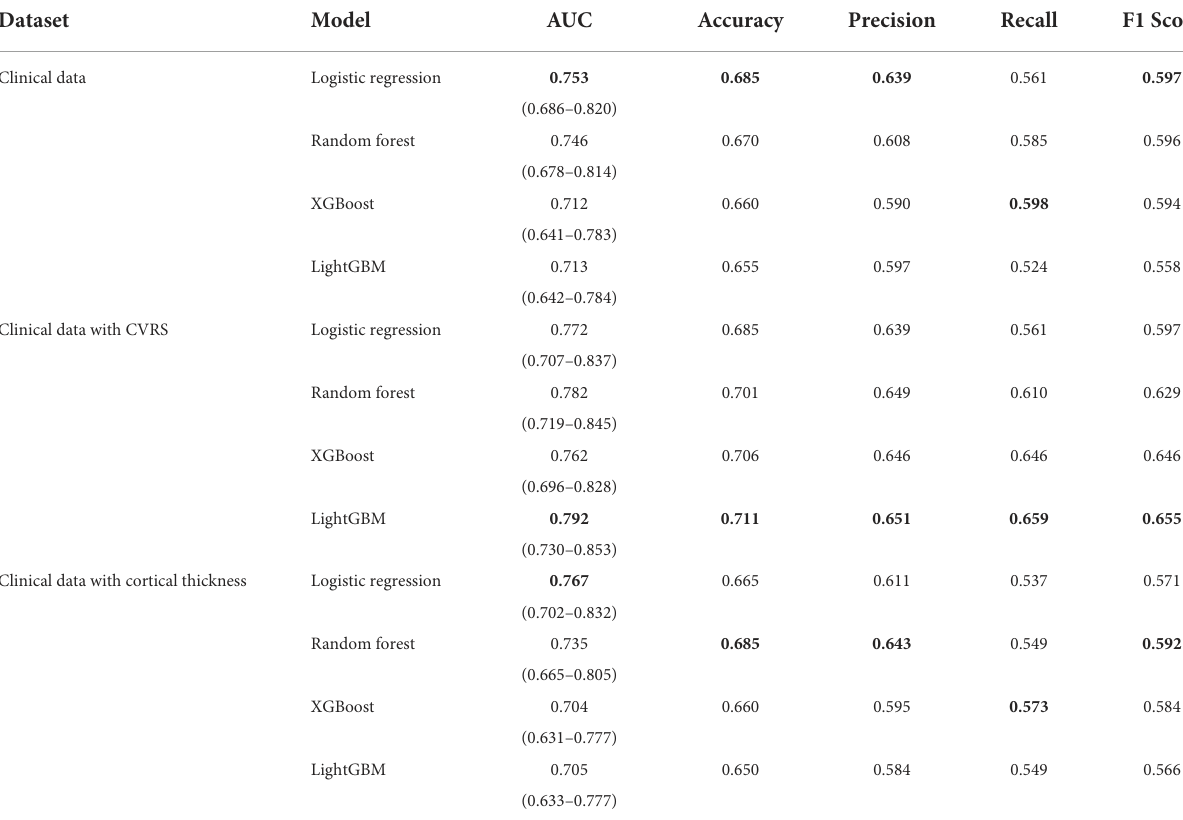
TABLE 3 The prediction performance of each ML model with leave-one-out cross-validation.